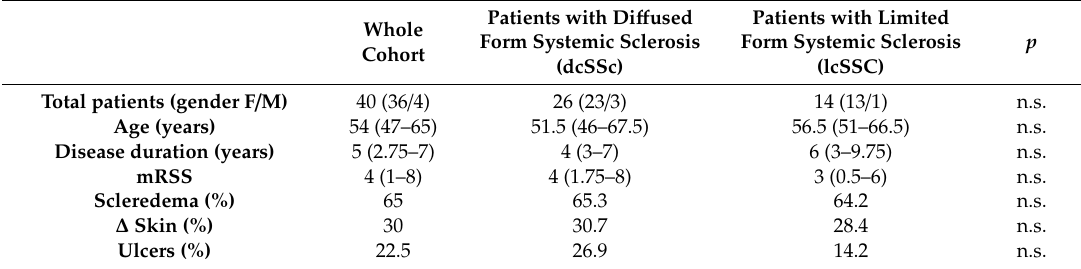
Table 1. Demographic data and clinical and radiographic features of the 40 patients with Systemic sclerosis, according to the European Scleroderma Study Group (ESSG) score and Wells